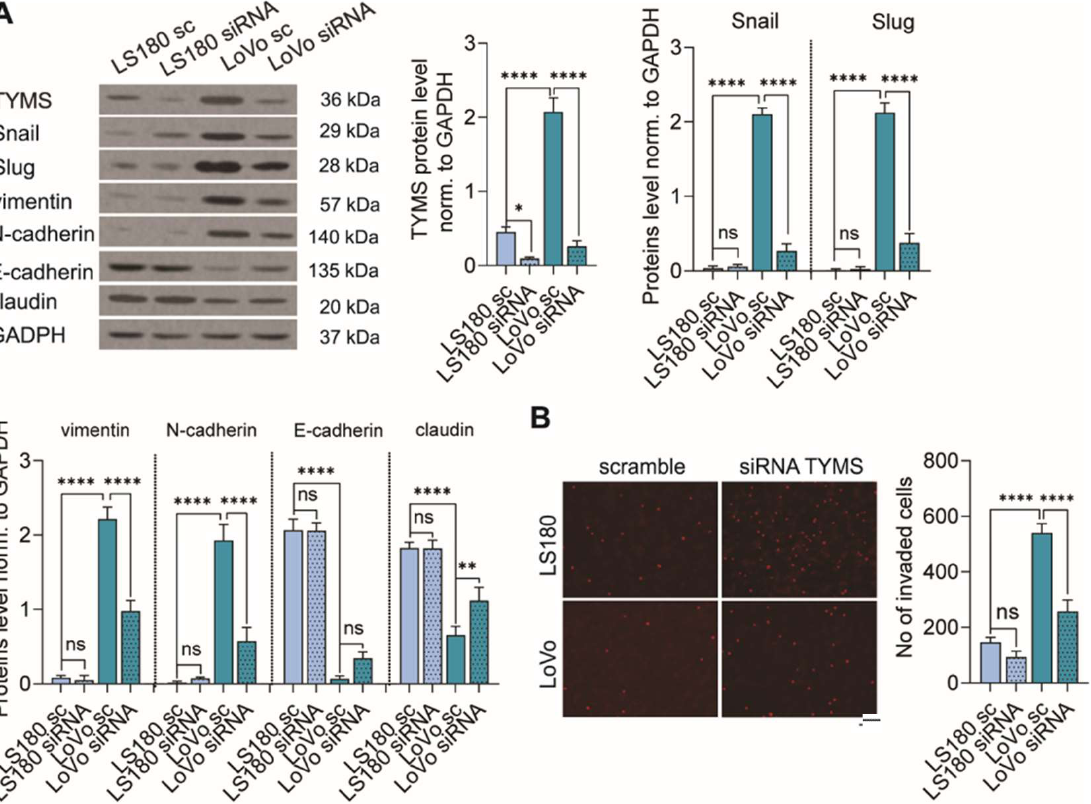
Figure 4. TYMS downregulation inhibited the EMT process and invasion of colon cancer cells. TYMS was downregulated with siRNA in colon cancer cells with different invasiveness properties and ( B ) TYMS overexpressing cells. ( A ) The effectiveness of TYMS-silencing and EMT markers was measured by Western blot. Representative blots are shown, and graphs displaying the mean protein level normalized to GAPDH ± SD ( n = 3). ( B ) An invasion assay was performed to analyze the effects of TYMS silencing on cell invasive properties. The representative images are shown. Scale bar 100 µm. The graph displays means ± SD ( n = 3). sc—scramble; siRNA—siRNA targeting